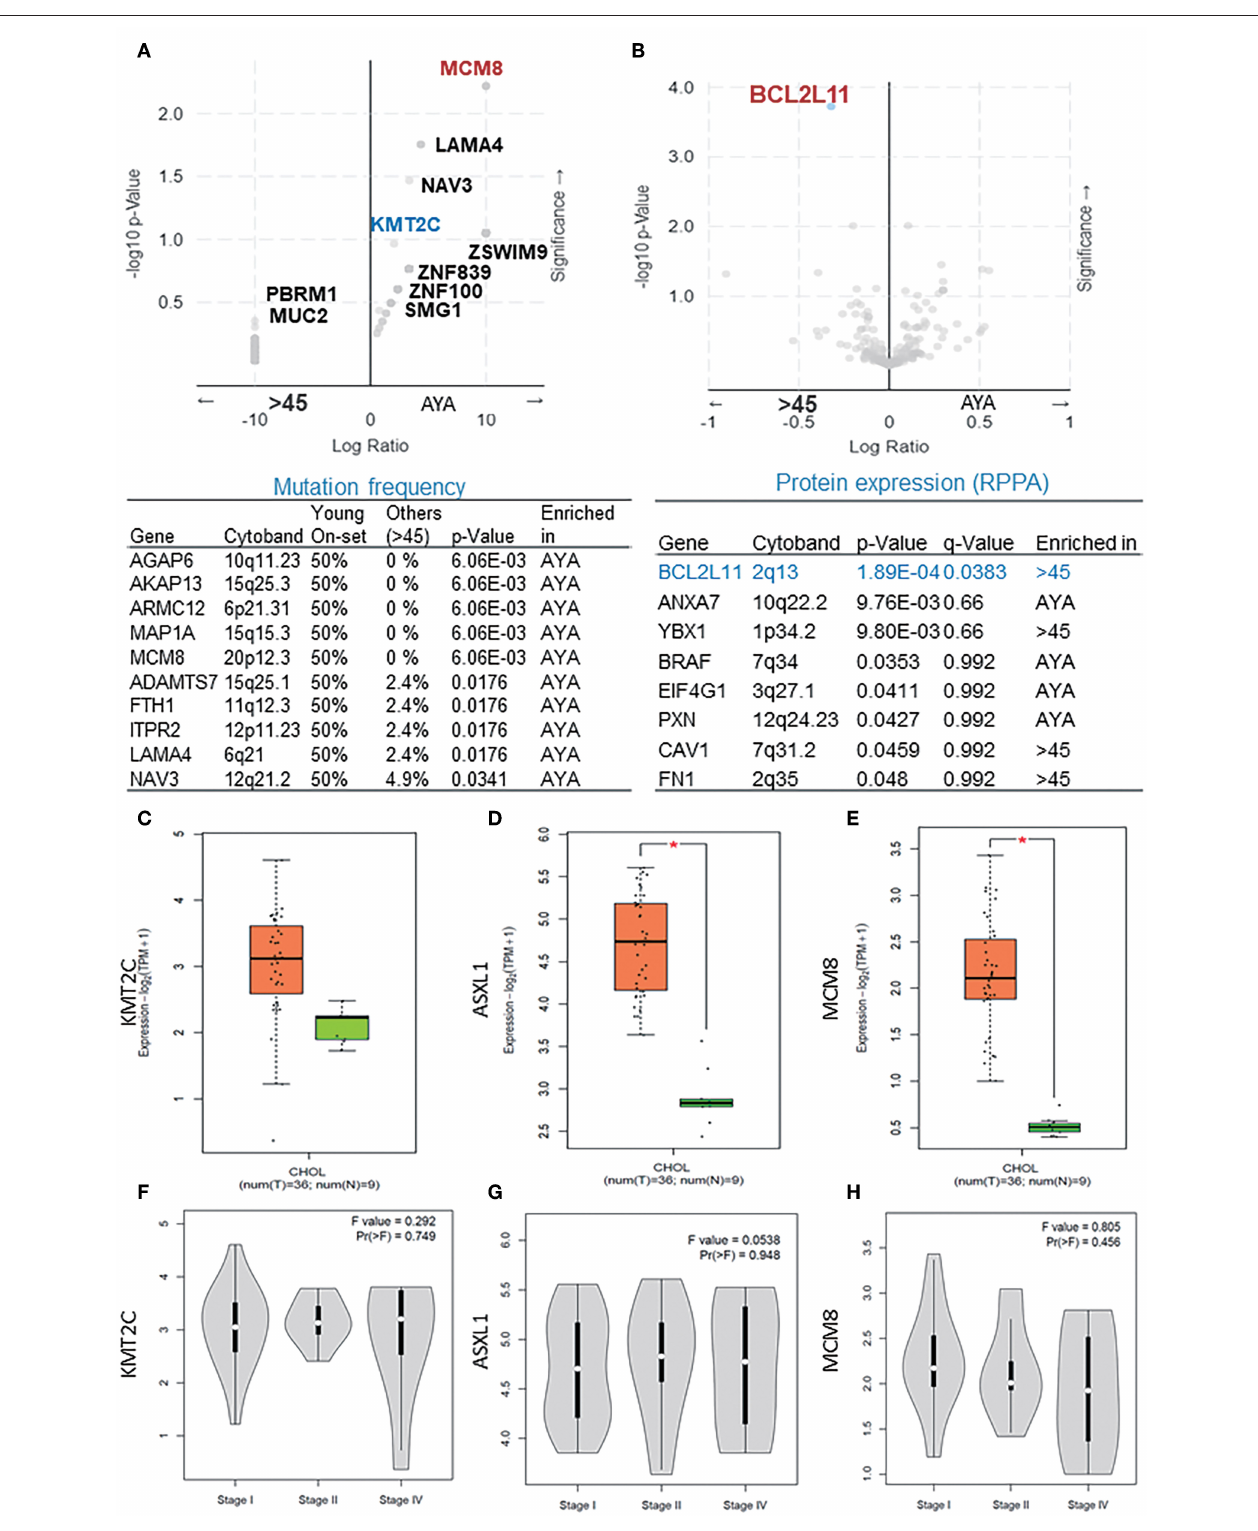
FIGURE 2 | (A) The mutation frequency of presentative genes ( p < 0.05) in AYA and other groups basing on cohort 2. (B) The difference of protein expression between the two groups basing on cohort 2. (C–E) The expression level of ASXL1, KMT2C, and MCM8 in tumor vs. paired normal samples in CCA. (F–H) Expression level of ASXL1, KMT2C, and MCM8 in different tumor stages. AYA, adolescents and young adults; ASXL1, additional sex combs like 1. * P < 0.05.